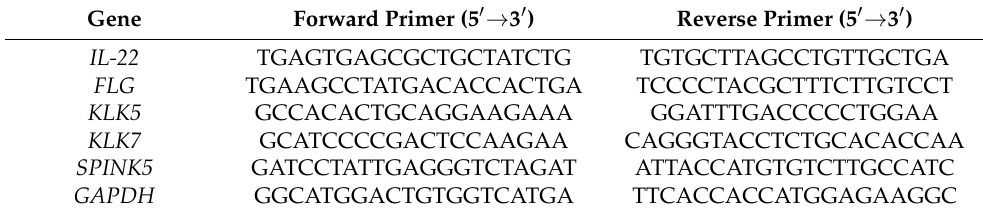
Table 1. Sequence of reverse transcription PCR